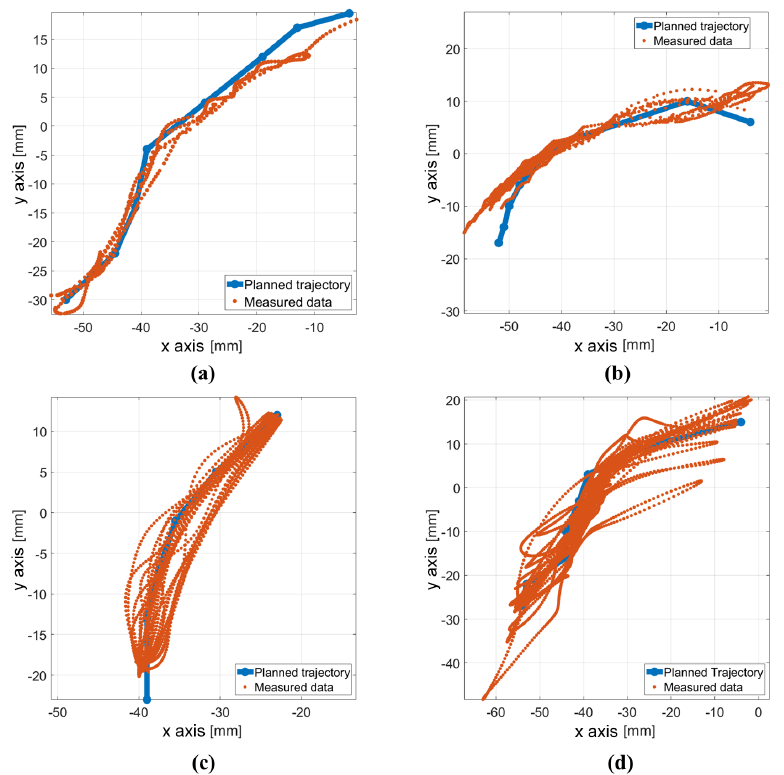
Figure 22. Comparison the planning trajectory and measurement data for each person in the FE